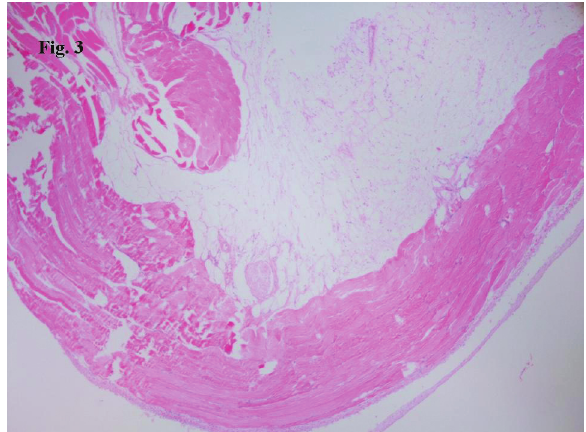
Table 3 - Intra-abdominal adhesions and histopathological fibrosis scores